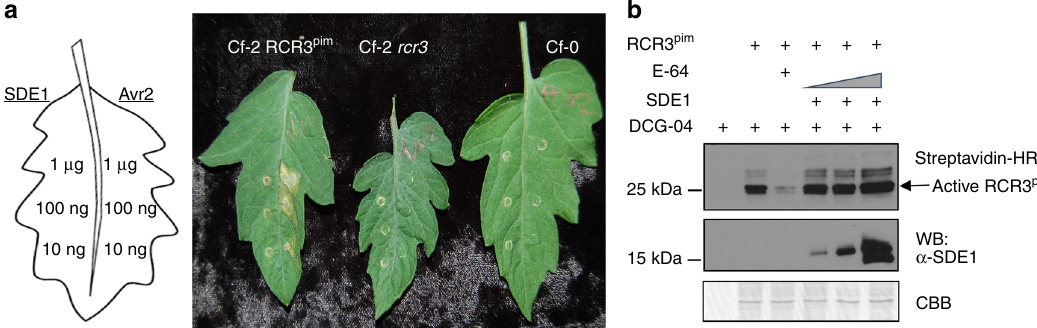
Fig. 6 SDE1 does not inhibit Solanaceous RCR3 activity. a SDE1 did not elicit cell death in tomato (Moneymaker, Solanum lycopersicum ) leaves expressing the immune receptor Cf-2. Puri fi ed recombinant proteins FLAG-Avr2-6XHIS or FLAG-6XHIS-SDE1 were in fi ltrated in tomato leaves in three different concentrations: 1 μ g, 100 ng, and 10 ng. Avr2 inhibits the protease activity of RCR3 pim (RCR3 from Solanum pimpinellifolium , which is required for Avr2- triggered cell death in tomato plants expressing Cf-2 produced by S . pimpinellifolium (left). Cf-0 (right) and Cf-2 rcr3 (middle, containing a rcr3 mutant with a premature stop codon) tomatoes were used as negative controls. Picture was taken after 7 dpi. b SDE1 does not inhibit the activity of RCR3 pim . Full length of RCR3 pim -HIS was transiently expressed in N . benthamiana and secreted into the apoplast. Apoplastic fl uid was extracted and the active protease was labeled via ABPP in the presence of 0.8, 1.6 or 3.2 μ M of puri fi ed SDE1 protein. Coomassie brilliant blue (CBB) served as a loading